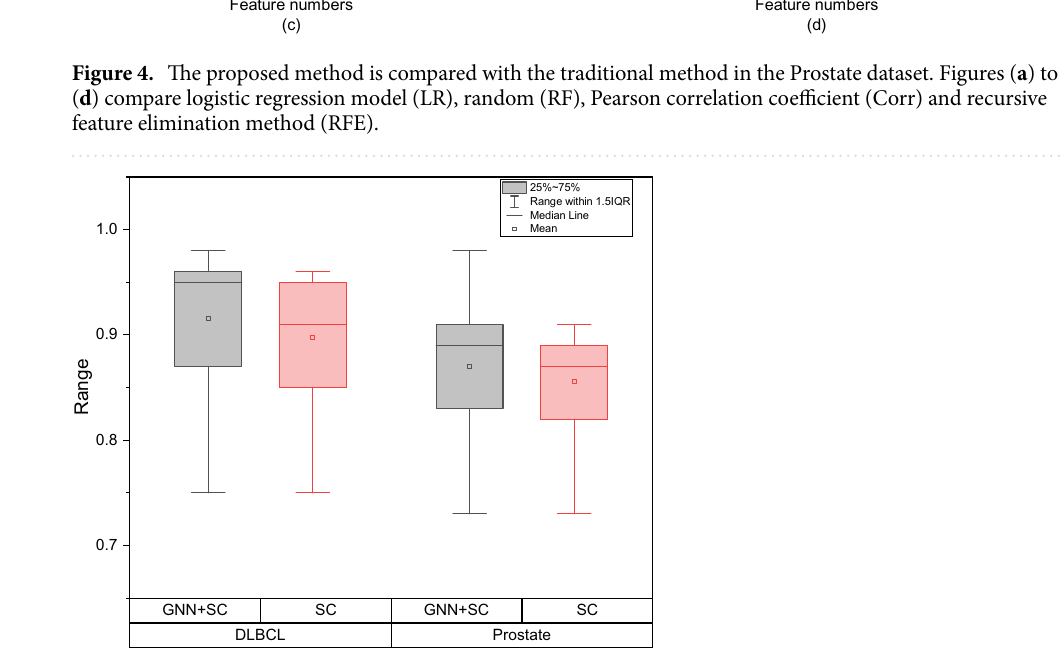
Figure 5. The impact of link prediction on classification results, the fluctuation range of classification accuracy is calculated on the vertical